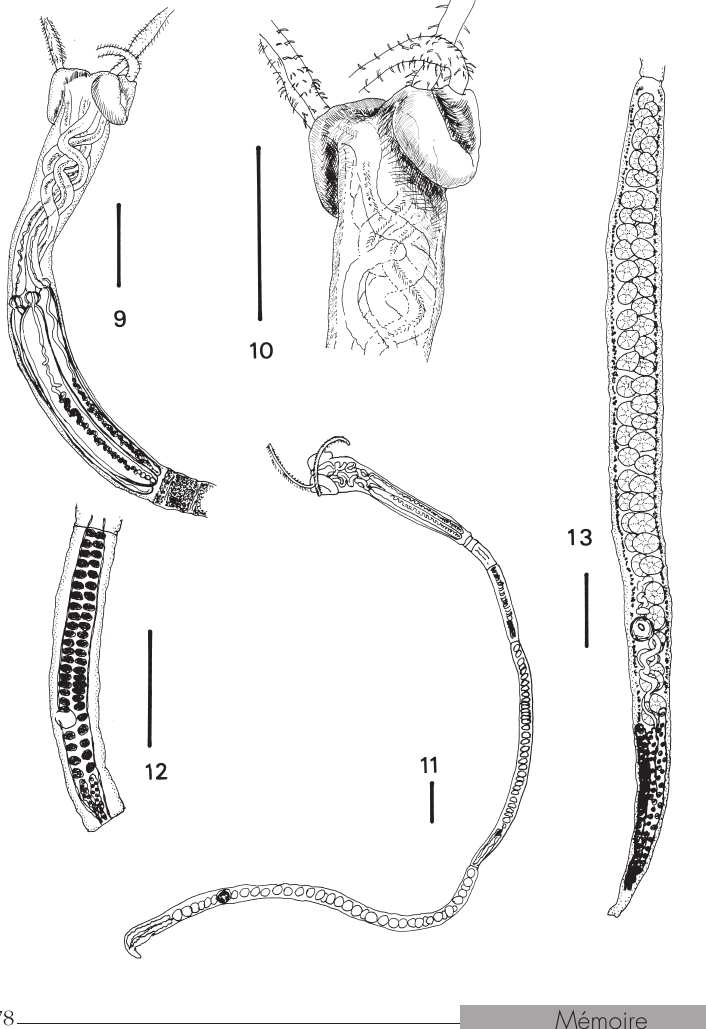
Fig. 10. Bothria. Fig. 11. Entire cestode. Fig. 12. Pre- mature segment. Fig. 13. Mature segment. Scale-lines: 0.1